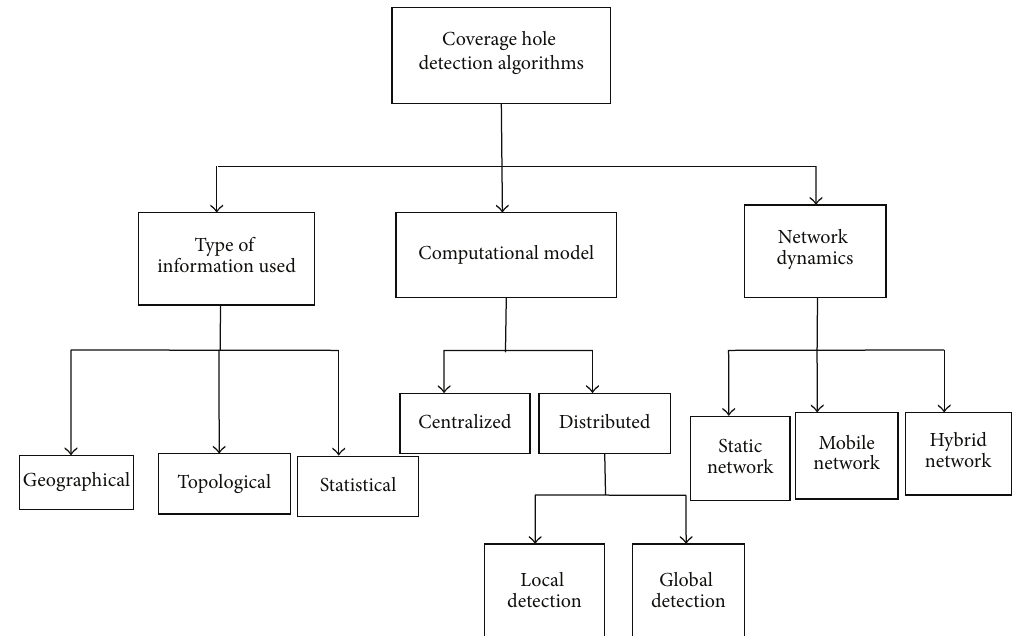
Figure 4: Coverage hole detection algorithm categorization in